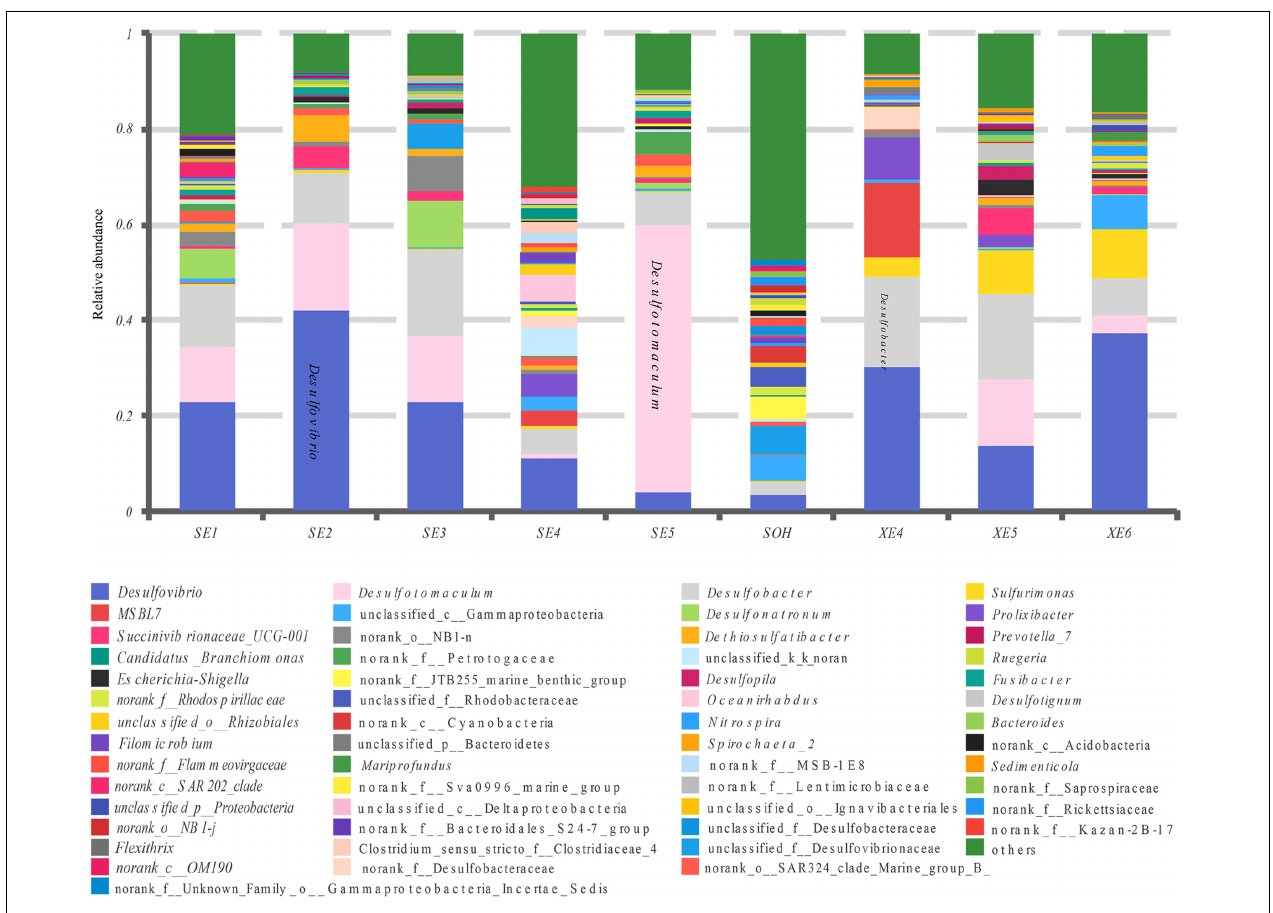
FIGURE 7 | Relative abundances of bacterial 16S rRNA gene sequences from the corrosion samples presented at the genus